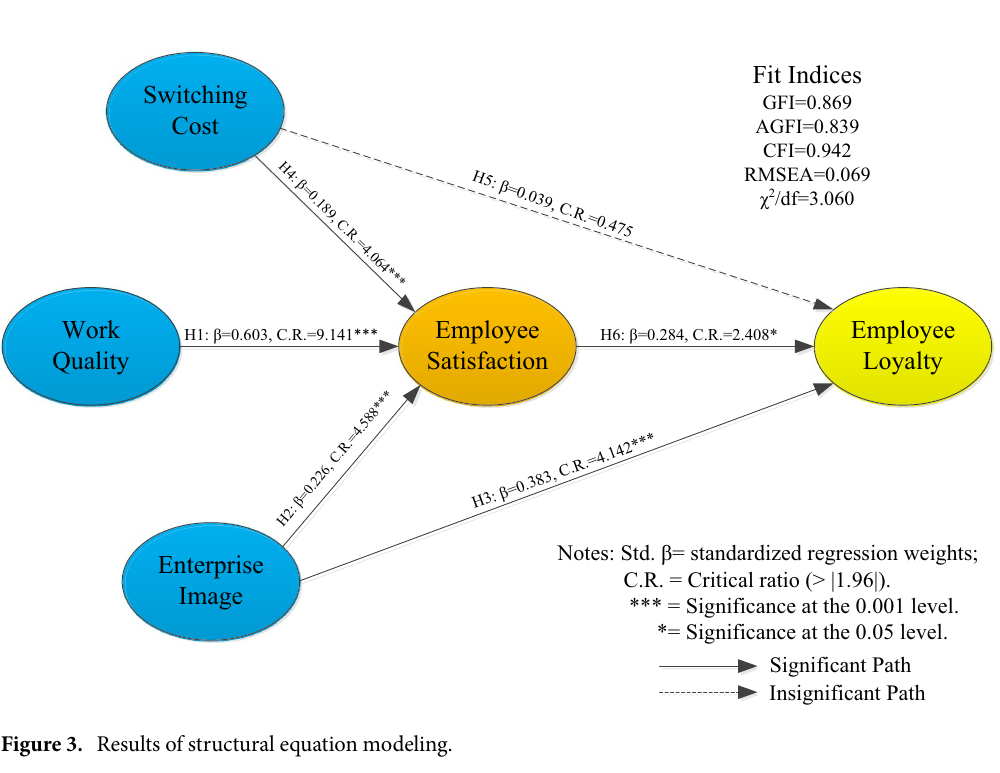
Figure 3. Results of structural equation modeling.